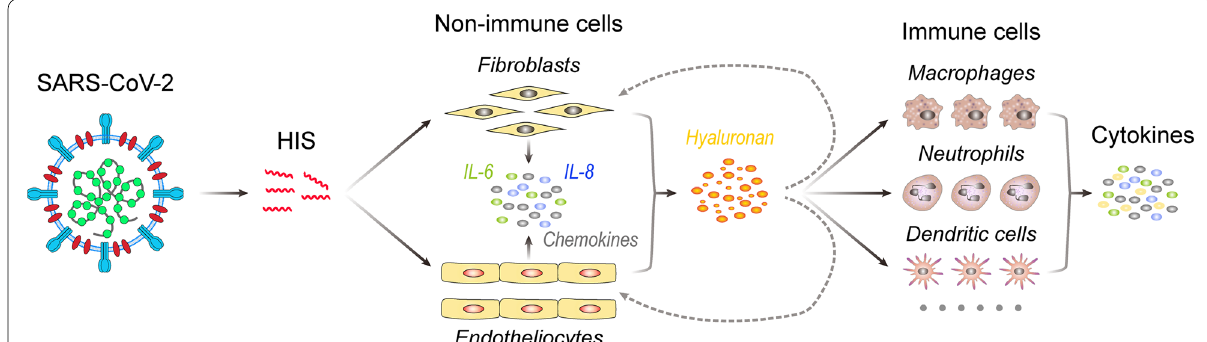
Fig. 3 The formation of cytokine storm in severe COVID-19. In fibroblasts and endotheliocytes, HIS generated by SARS-CoV-2 could activate HAS2 expression and promote the hyaluronan. Then, hyaluronan is degraded into different fragments. The low molecular weight of hyaluronan can bind to its receptors in non-immune cells and immune cells and produce different cytokines, including IL-6, IL-8, and chemokines, resulting in cytokine storm in